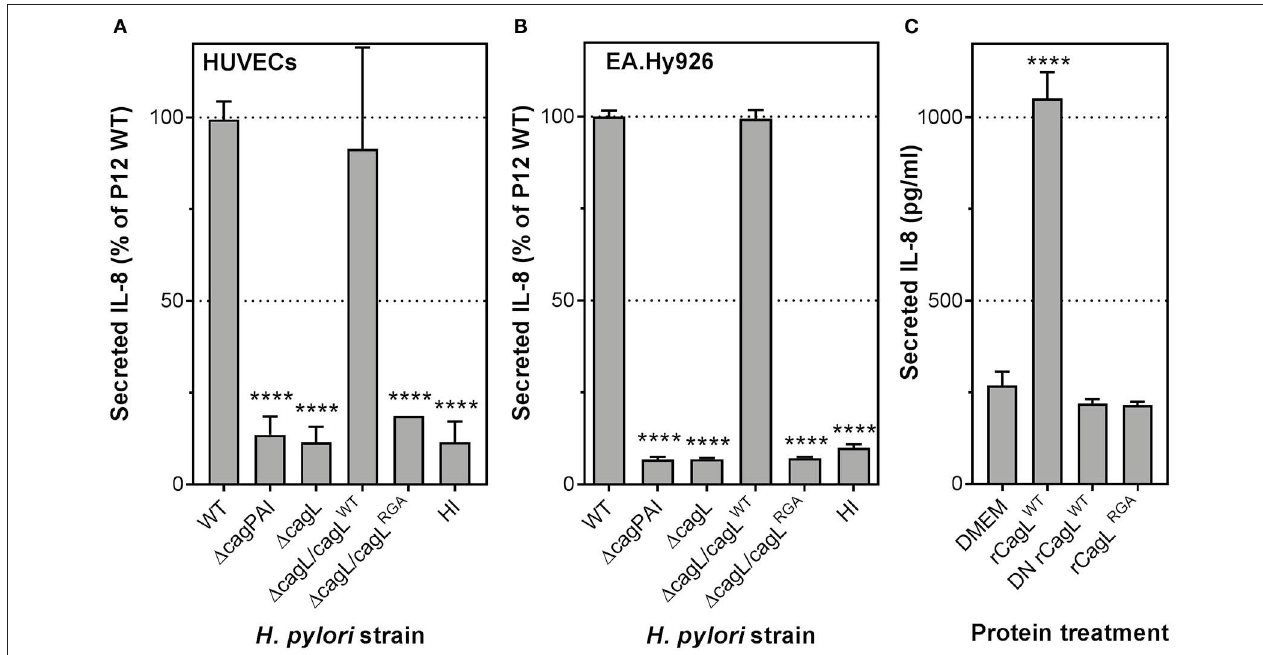
FIGURE 2 | H. pylori T4SS, via the CagL adhesin, plays an essential role in IL-8 induction in infected human endothelial cells. Mean secreted IL-8 levels in spent culture medium collected from (A) HUVECs or (B) EA.Hy926 cells inoculated with heart infusion broth (HI), H. pylori P12 wild-type (WT), or isogenic 1 cagPAI and 1 cagL mutants at 24 hpi; MOI = 1. Error bars denote SEM, N = 3; statistical analysis using two-way ANOVA (Tukey’s multiple comparisons post-test); ****denotes conditions significantly different ( p < 0.0001) to WT. (C) Mean secreted IL-8 levels in spent culture medium collected from EA.Hy926 cells incubated for 24h with DMEM media or 100 µ g/ml recombinant CagL wild-type (rCagL WT ), heat-inactivated CagL (DN rCagL WT ) or CagL RGA mutant protein (rCagL RGA ). Error bars denote SD , N = 4; statistical analysis using one-way ANOVA (Tukey’s multiple comparisons post-test).